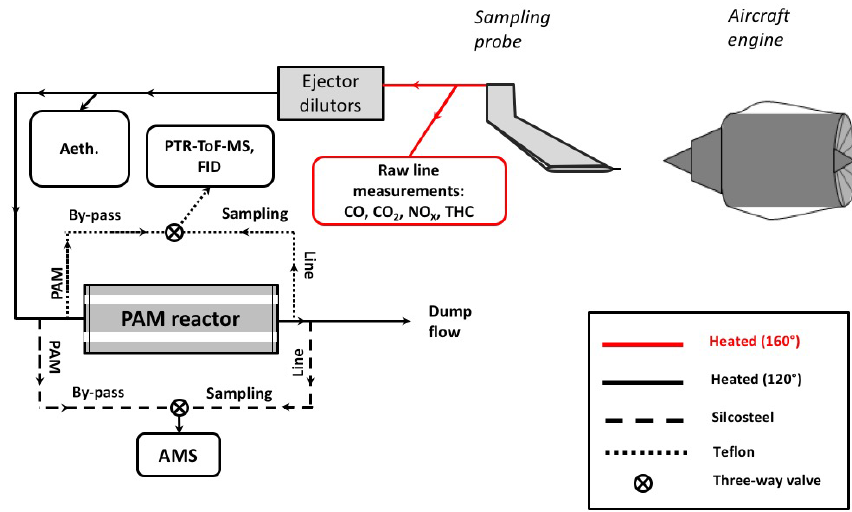
Figure 1. Simplified scheme of the experimental